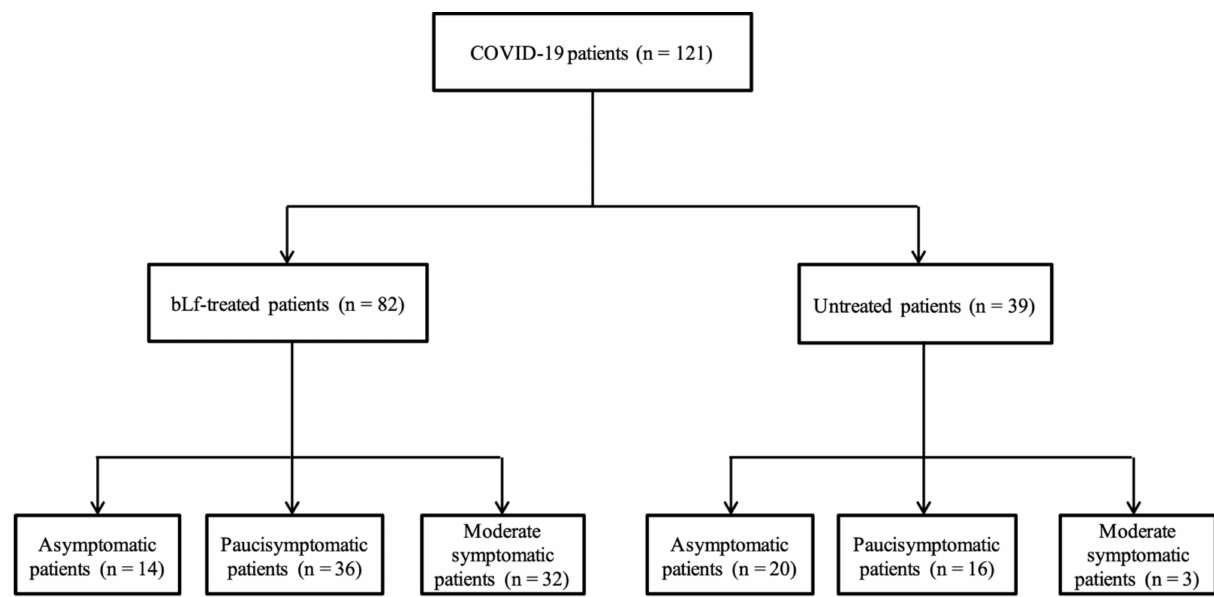
Figure 1. A total of 121 patients with confirmed COVID-19 infection at reverse transcriptase real-time (rRT)-PCR were involved in the study: 82/121 bovine lactoferrin (bLf)-treated and 39/121 bLf-untreated.